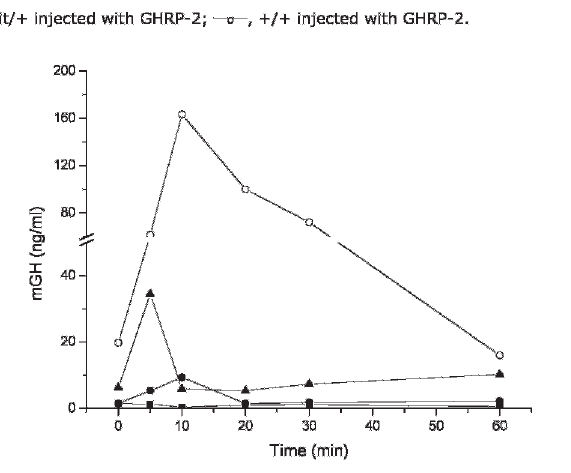
Figure 2 - Mouse GH (mGH) serum concentrations were determined by a sensitive RIA method (detection limit, 0.25 ng/ ml). Shown here are the mGH increases after the acute administration of 10 m g GHRP-2 in lit/lit, lit/ + and + / + mice as well as the saline injection of lit/lit mice. Three animals were used for each time point only once each and then sacrificed. In